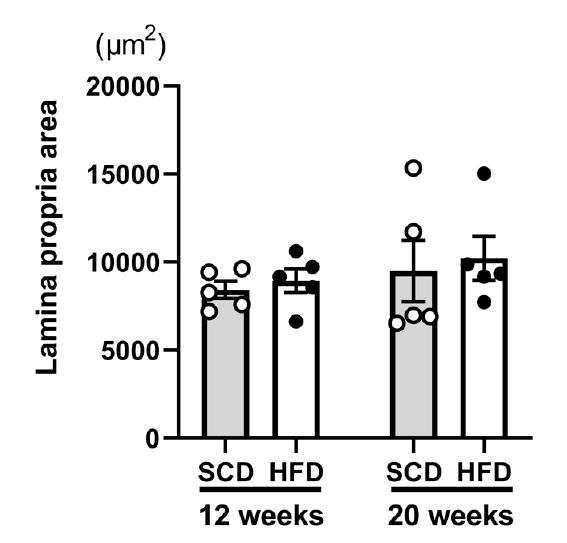
Figure 4. Comparison of the areas of the lamina propria used in quantitative analyses. There were no differences in the areas of the lamina propria analyzed either between the age groups (12-week and 20-week) or between the diet models (standard chow diet and high-fat diet) (Two-way ANOVA). The same number of animals was used in all groups ( n = 5 per group).